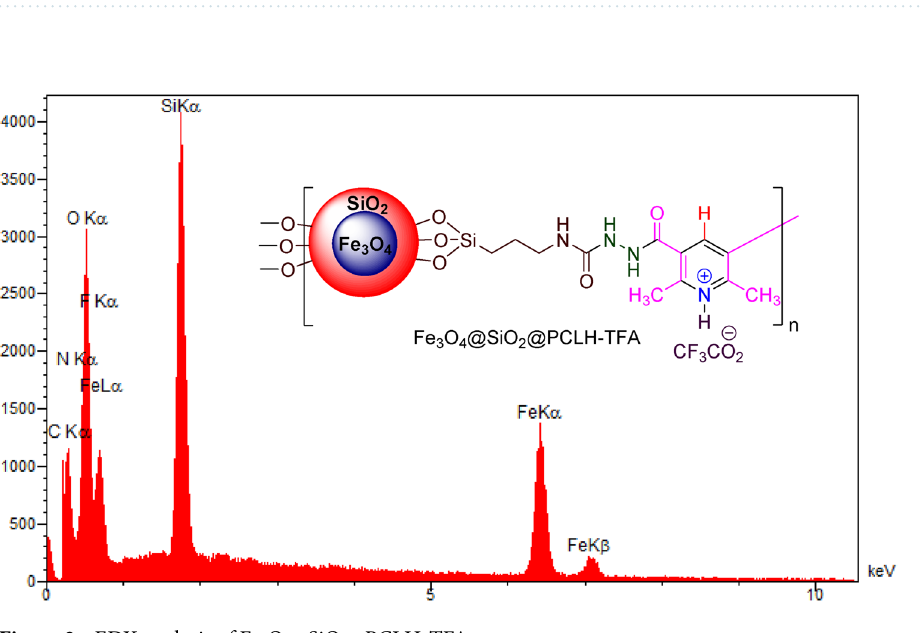
Figure 2. EDX analysis of Fe 3 O 4 @SiO 2